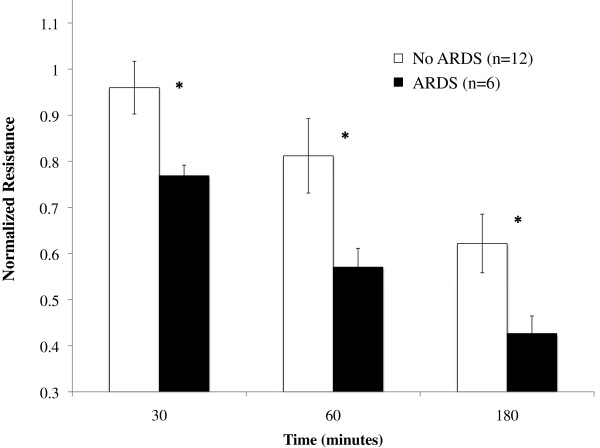
Neutrophils from acute respiratory distress syndrome patients induce greater endothelial barrier dysfunction. Change in monolayer resistance at 30 minutes, 60 minutes, and 180 minutes. Groups were analyzed using two-way analysis of variance with Holm–Sidak post-hoc analysis. Values presented as mean ± standard error of the mean. Neutrophils from septic patients with acute respiratory distress syndrome (ARDS) produced greater loss of barrier function than those obtained from septic patients without ARDS. *P <0.05.